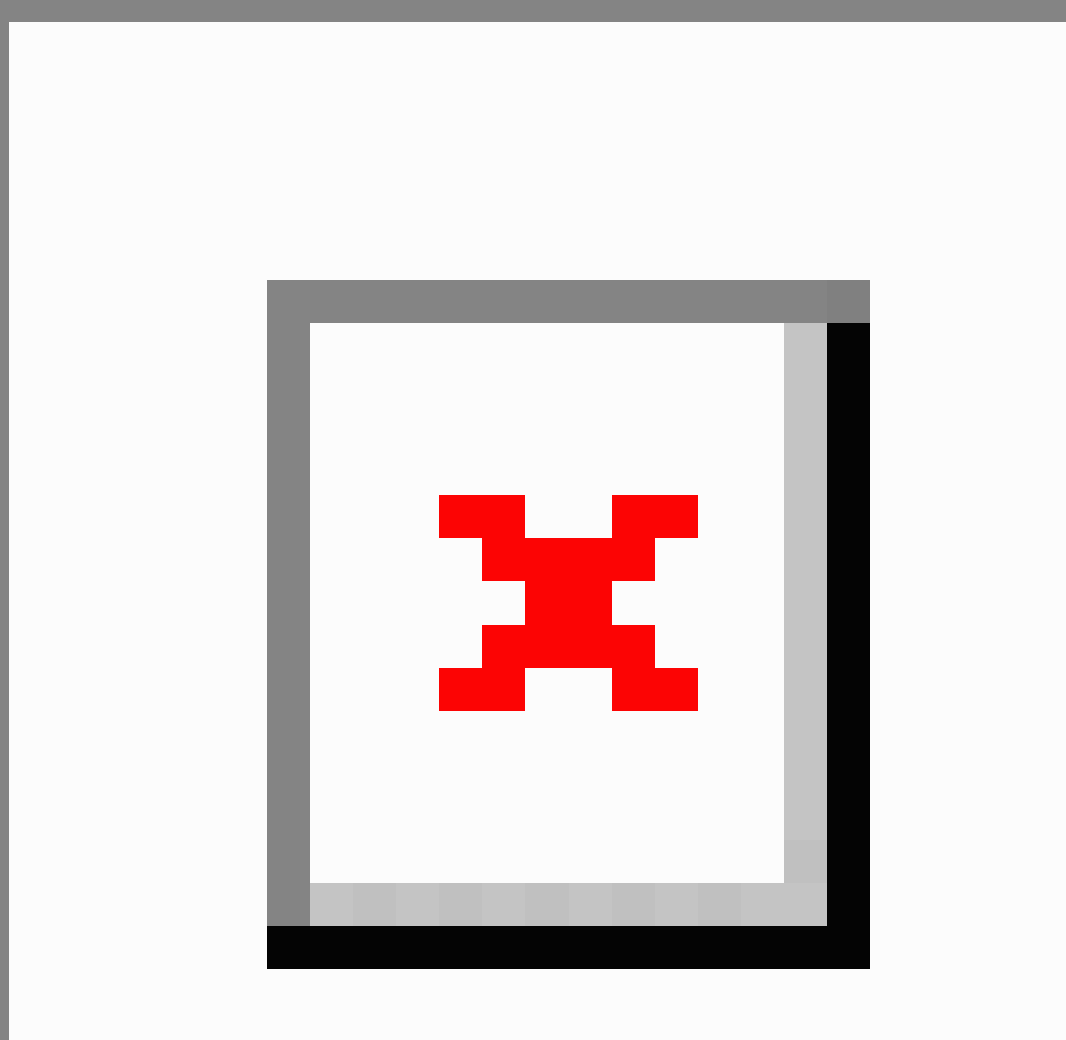
Figure 3. Expected within-community epidemic size assuming that communities were approximately random networks and maintained their empirical within-community degree distributions (colored lines; primary y-axis). The epidemic threshold for each community (ie, R 0 value for which transmission is sustained) is lowest for community III, followed by communities I and II. The frequency of multiwave epidemics depended on R 0 and is highest when R 0 =2.4 (gray line; secondary